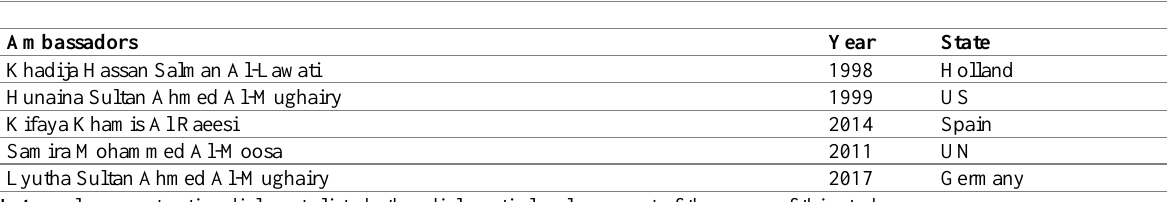
Table 2 : Omani women